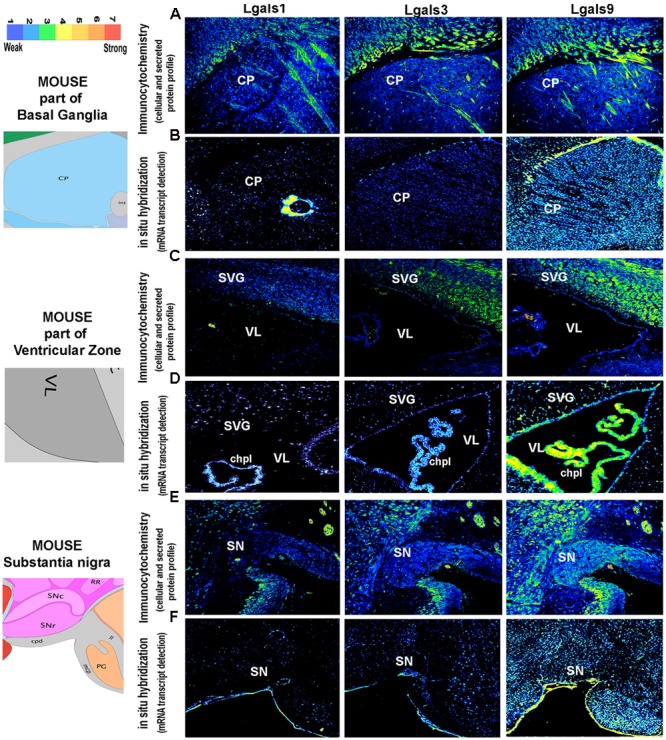
Comparison and validation of galectins mRNA expression with protein profiling in mouse Basal ganglia, Ventricular Zone and Substantia nigra. (B,D,F) ABA based mRNA expression profile of 3 major galectins in the Striatal Caudoputamen (CP, site of activity dependent synaptic plasticity, motor control and procedural memory) region of the basal ganglia, Ventricular zone: VL (in the vicinity of neurogenic subventricular zone, SVG; and choroid plexus: chpl) and Substantia nigra (SN, motor control region) is compared with immunohistochemistry based protein expression in the respective regions as shown in (A,C,E). Pseudo-color calibration bar is included to represent the intensity of expression. Note a good regional corroboration between mRNA and protein expression except that the protein expression is more widespread due to the secretory nature. The protein is also detected in the extracellular space and on the surface of cells is suggestive of autocrine-paracrine effects.